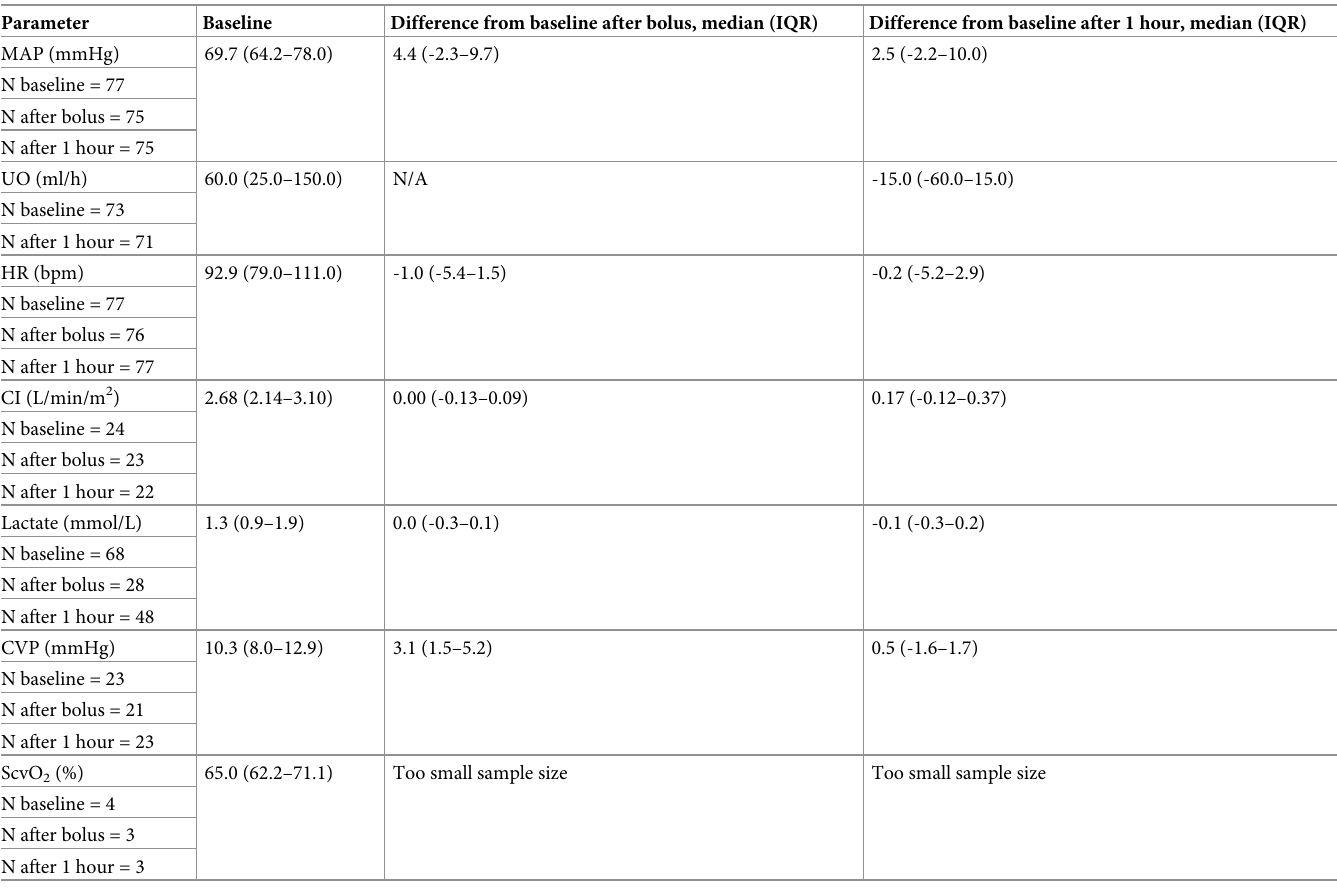
Table 4. Effects of the fluid